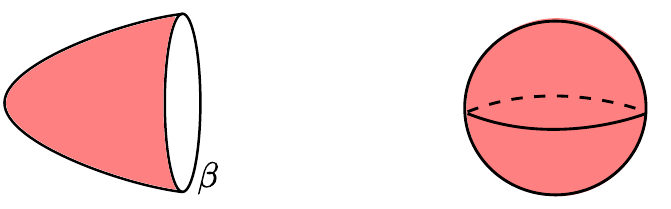
Figure 10 . Left: the thermal circle β caps off smoothly in the Euclidean black hole spacetime, at a special point dictated by the time of the asymptotic exterior observer. Right: in Euclidean de Sitter every point is equivalent, although we can write it as an S 1 × S d − 2 fibered over an interval in an infinite number of ways, with the S 1 degenerating to zero size at any point on the sphere that we wish. This freedom corresponds to the choice of